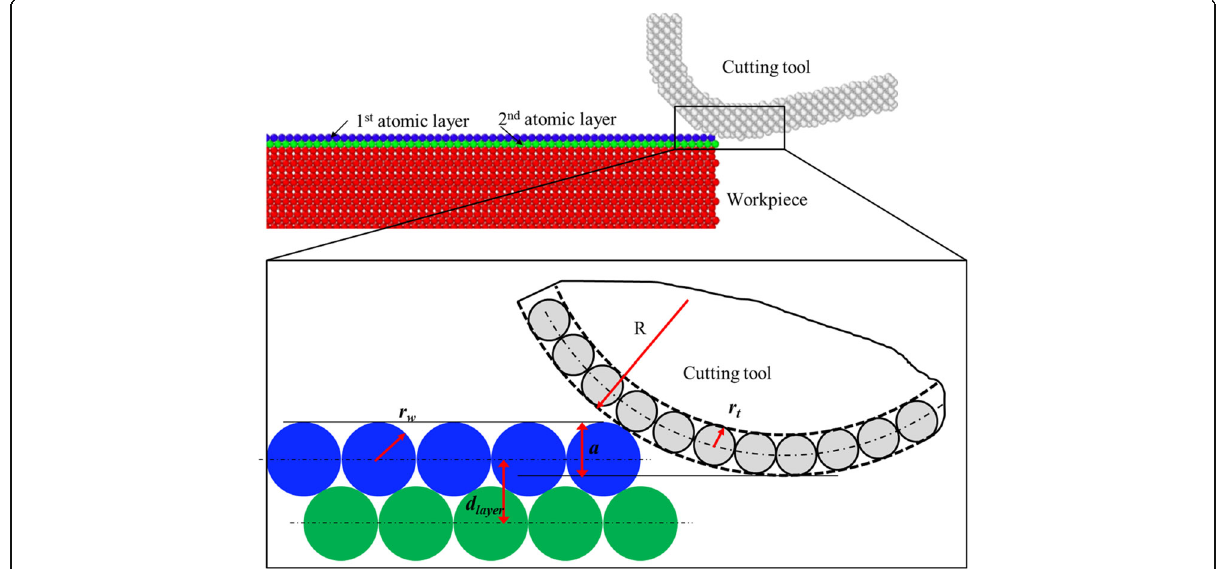
Fig. 2 Schematic diagram for the cutting depth definition in single atomic layer